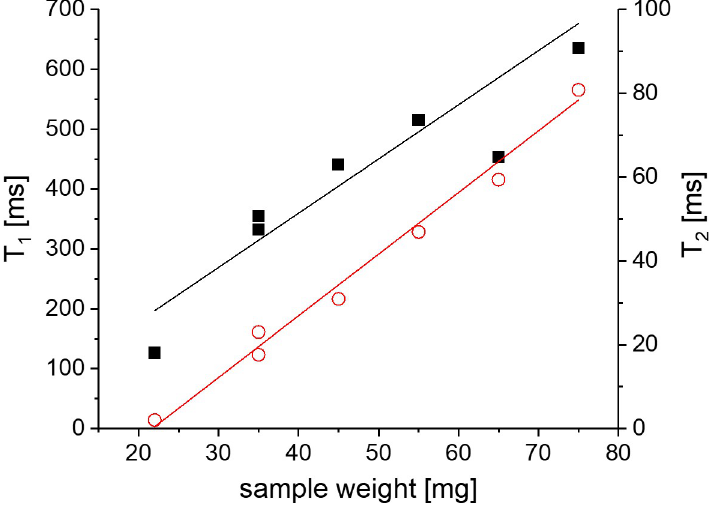
Fig 11. Dependence of relaxation times T 1 (black solid symbols) and T 2 (red open symbols) at a magnetic field strength of 1.0 T for a partially dried cartilage sample (labeled as D1 to D5) as a function of sample weight. Solid lines are the best fits to linear